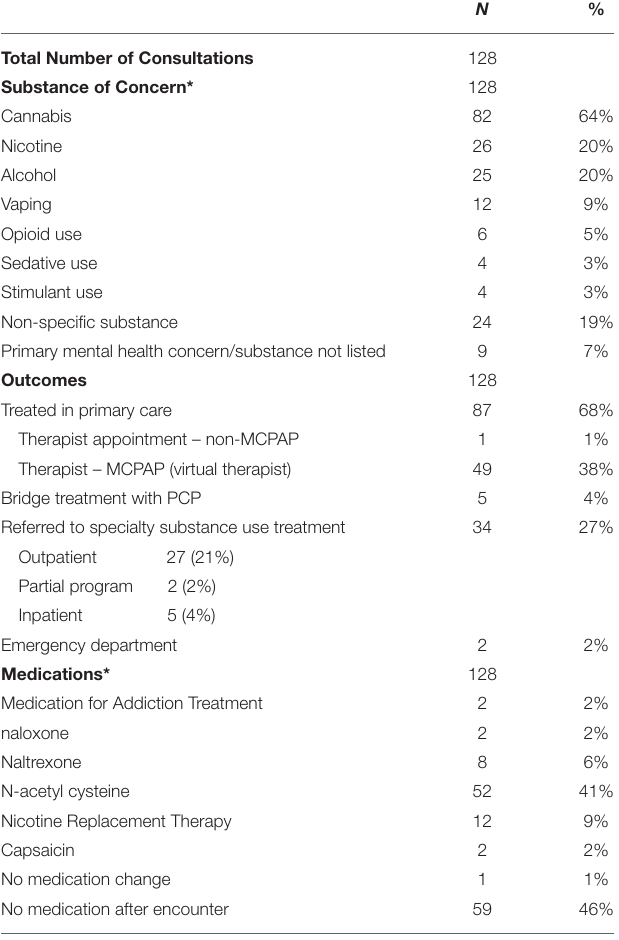
TABLE 1 | Description of